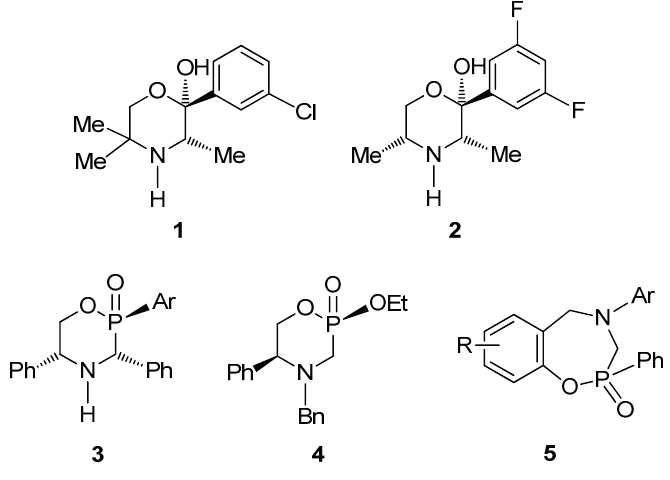
Figure 1. 2-Arylmorpholinols, α -aminophosphonic and α -aminophosphinic